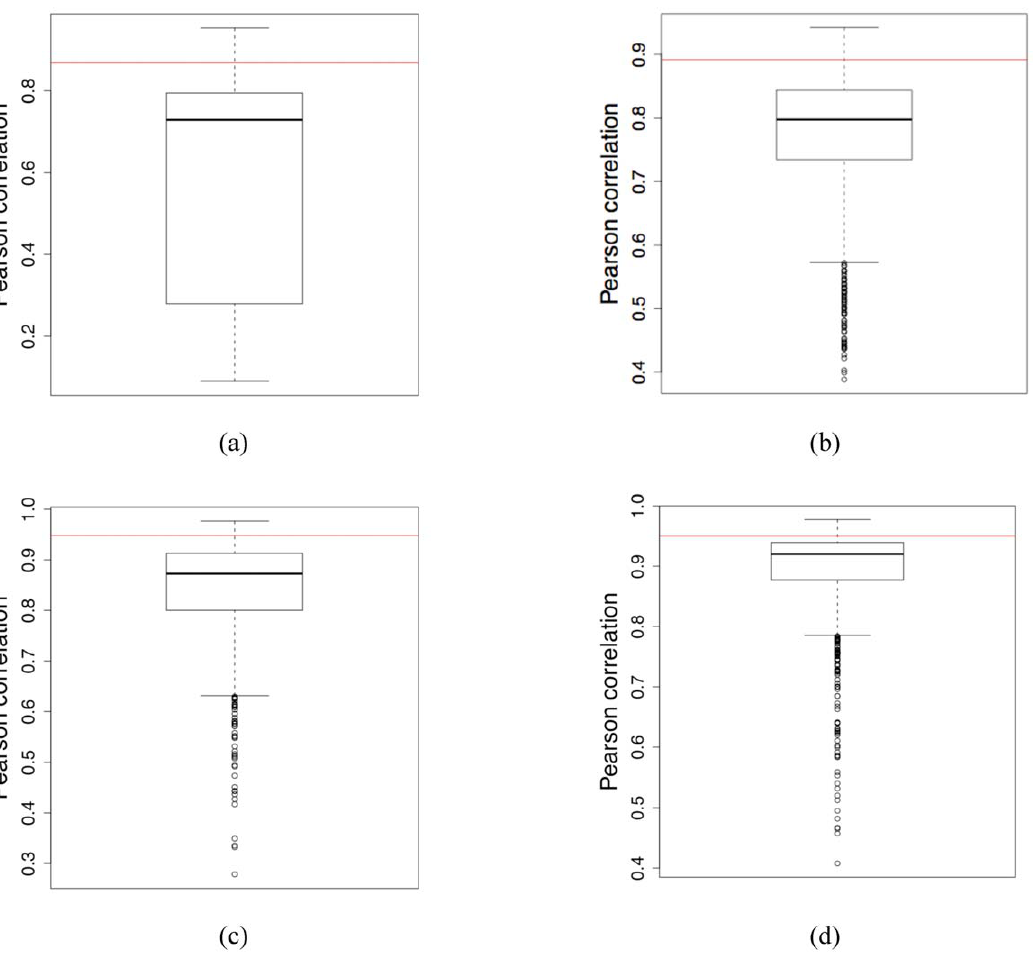
Figure 9. Boxplots describing the ensemble of Pearson correlations coefficients comparing each PG realization to the PG behavior. The red line represents the correlation between the PG and the VPG. In all cases, the PG to VPG similarity is greater than the 75th percentile of the intrinsic fluctuations within the PG ensemble.